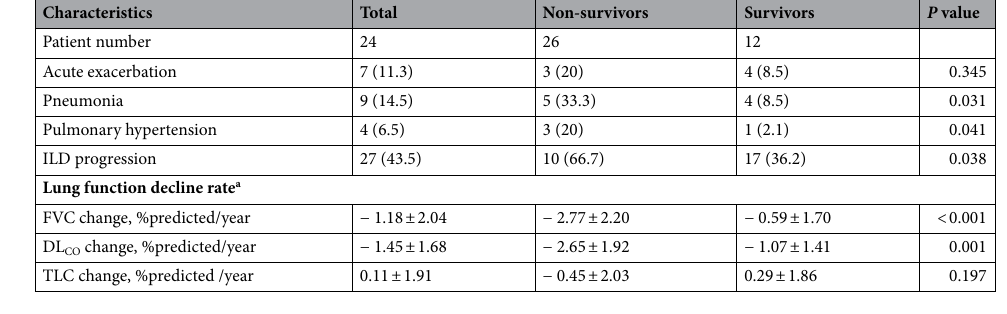
Table 2. Comparison of clinical course between non-survivors and survivors among patients with SJS-ILD. Data are presented as mean ± standard deviation or number (%), unless otherwise indicated. DL CO diffusing capacity of the lung for carbon monoxide, FVC forced vital capacity, ILD interstitial lung disease, SJS Sjögren syndrome, TLC total lung capacity. a Lung function decline rate was defined as the slope of linear function estimated using a linear mixed-effects model with random intercept and random